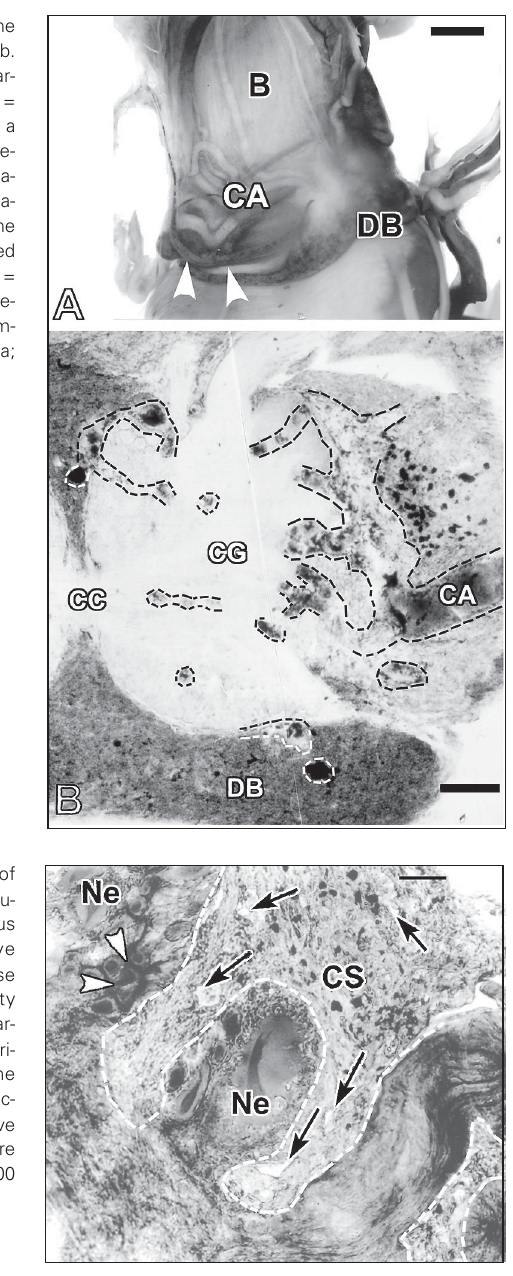
Figure 2. A , Dorsal view of the cerebral ganglia and buccal bulb. Note the vessels filled with car- mine-gelatin (arrowheads). Bar = 2 mm. B , Photomicrograph of a horizontal section of the cere- bral ganglion after carmine-gela- tin injection through the circula- tory system. The limit where the vessels are located is identified by a discontinuous line. Bar = 0.5 mm. B, buccal bulb; CA, ce- rebral artery; CC, cerebral com-